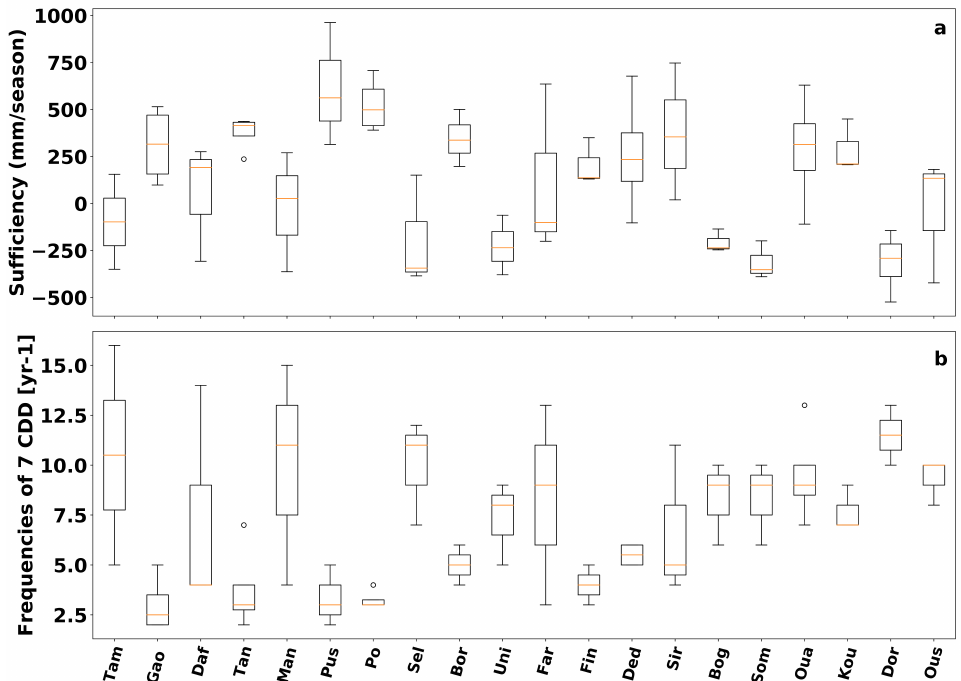
Figure 2. ( a ) Average rainfall sufficiency in the growing season (from May to October), computed as the difference between daily precipitation and evapotranspiration. Evaporation computed following Makkink [24]. ( b ) Frequency of 7-day consecutive dry days (CDD), mean, and variability over the study period. Stations are ordered by increasing latitude from left to